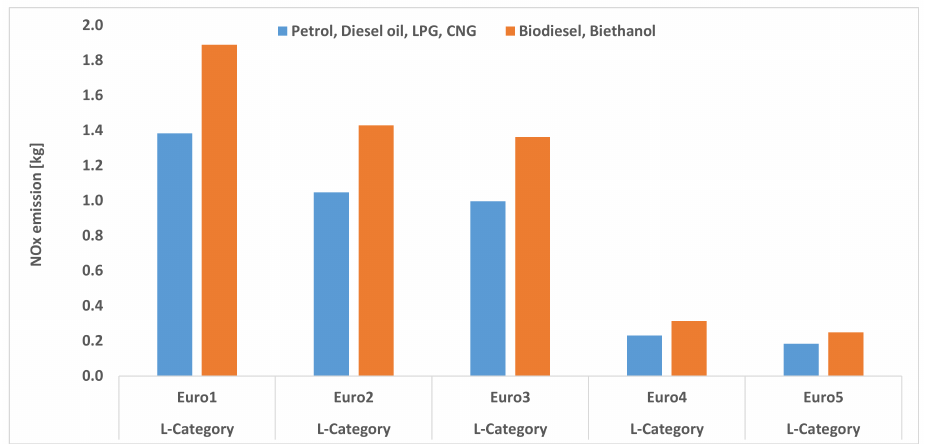
Figure 11. Comparison of NO X emissions from L-category vehicles depending on Euro standard and fuel type.